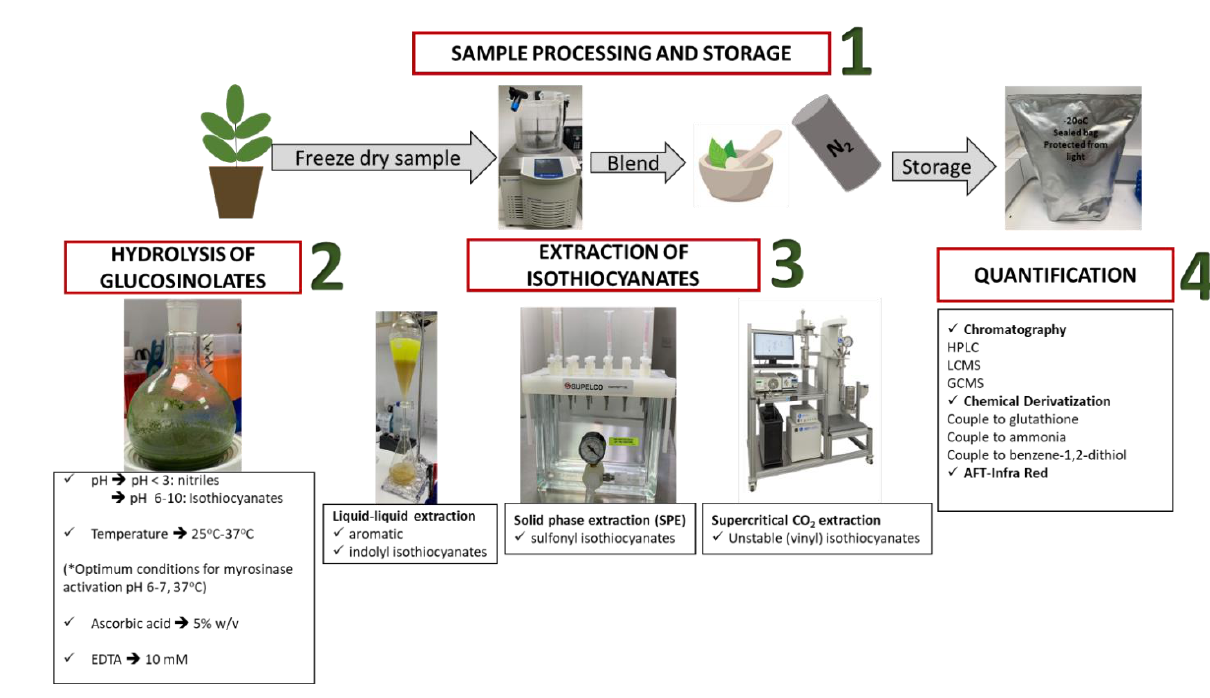
Figure 4. The 4 pillars: (1) sample processing and storage, (2) hydrolysis of GSLs, (3) extraction of ITCs, and (4) quantification for the determination of ITCs from naturally—derived sources.